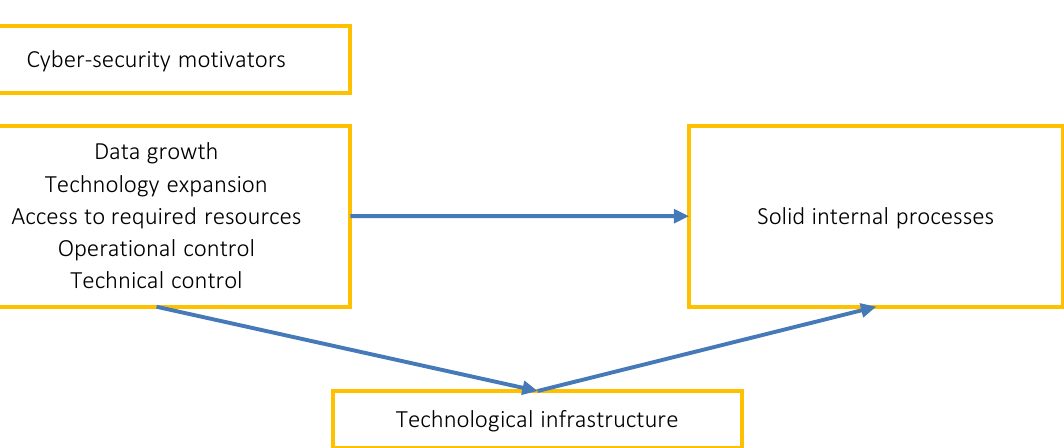
Figure 1. Conceptual framework relating cyber-security motivators to technological infrastructure and internal processes